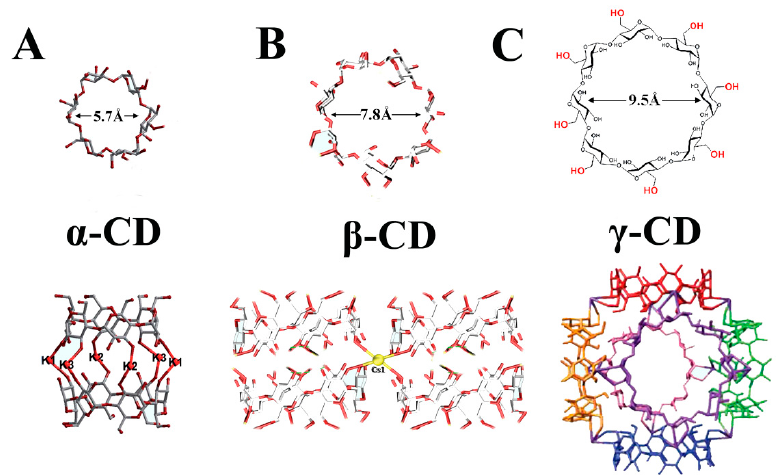
Figure 1. Structural representations of three types of cyclodextrins (CDs) and a schematic diagram of coordination between α / β / γ CDs and metal ions. ( A ) The [K 6 (CD) 2 ] dimer torus. ( B ) View of two pairs of β -CD molecules combined with the individual Cs + ion; they have the reverse packing arrangement. ( C ) ( γ -CD) 6 cube of CD-MOFs. Reprinted with permission from [61–64] , Copyright ACS, 2011;